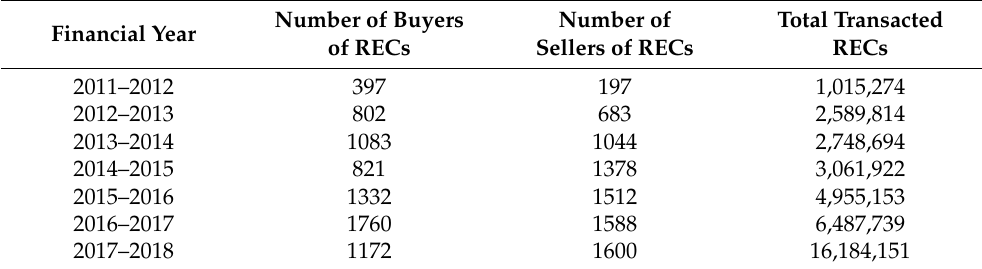
Table 21. Numbers of buyers, sellers and number of Renewable Energy Certificates trading on Power Exchanges. Source: Central Electricity Regulatory Commission